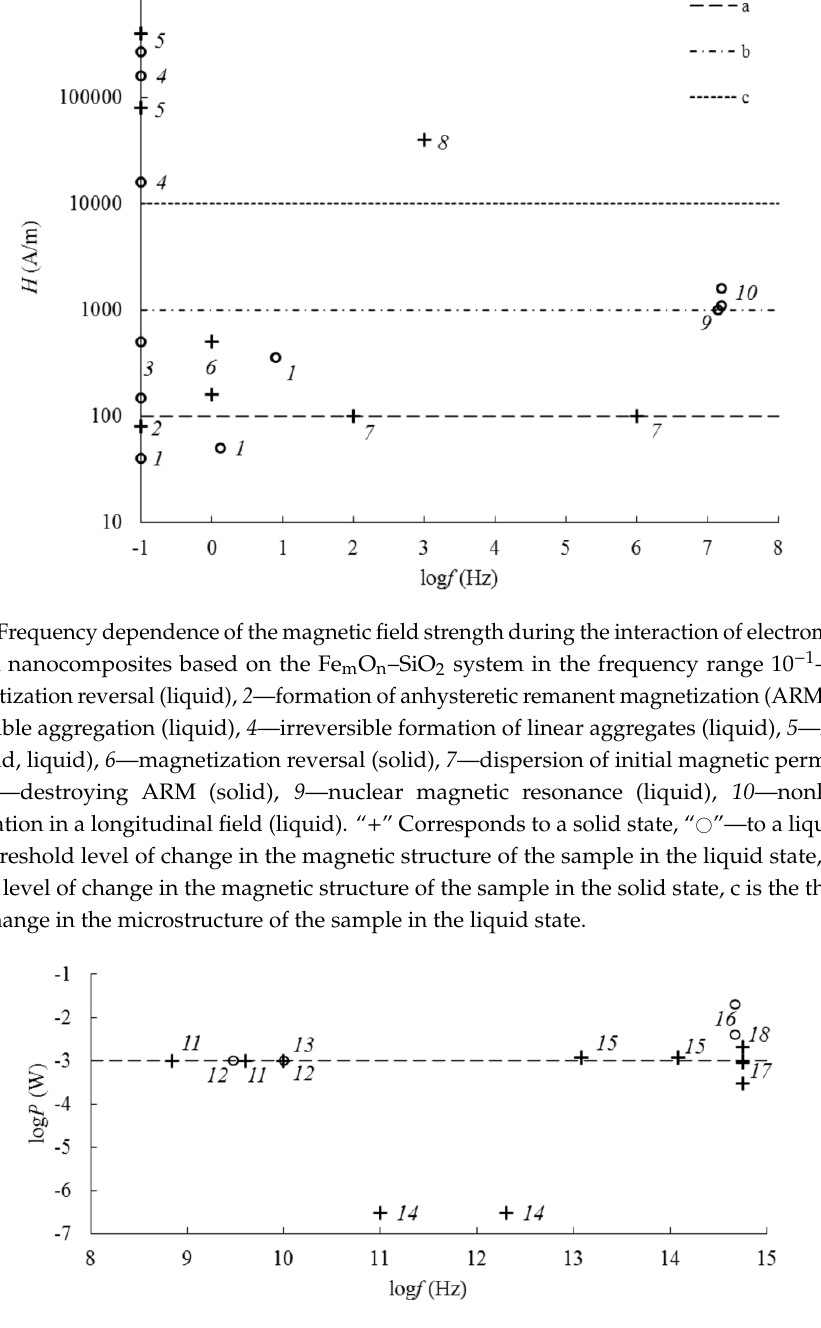
Figure 4. Frequency dependence of the characteristic energy of quanta during the interaction of electromagnetic field with nanocomposites based on the Fe m O n –SiO 2 system in the frequency range 10 13 –10 21 Hz: 15 —absorption on vibrations of Si–O–Si groups (solid), 19 —intrinsic absorption in iron oxide and silica (solid, liquid), 20 —X-ray diffraction on the crystal lattice (solid), 21 —Mössbauer effect (solid), 22 —radiation-induced phase transition magnetite → maghemite (solid). “+” corresponds to a solid state, “ ○ ” corresponds to a liquid state. The dashed line corresponds to the threshold level of change in the crystalline structure. The research has shown that when a certain level of EMF influence on nanocomposites is exceeded, a directional change in their magnetic structure, crystalline structure and microstructure is possible: the formation of stable linear aggregates of NPs, a change in the magnetic state and phase transitions of iron oxides. The change in the microstructure of the nanocomposites represented the formation of linear aggregates under the influence of high-strength QSMF (Table 2). When the threshold level of exposure, corresponding to the strength of the QSMF ~10 4 A/m (Figure 2), is exceeded, the formation of stable aggregates sedimenting in a colloidal solution was observed [14,18].